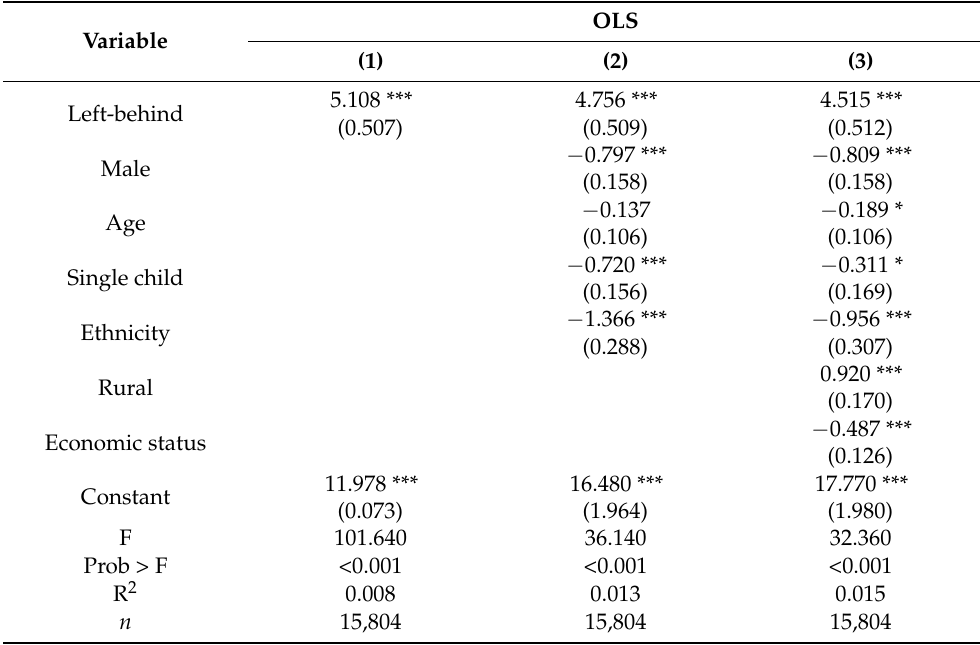
Table 6. Linear regression model for mental